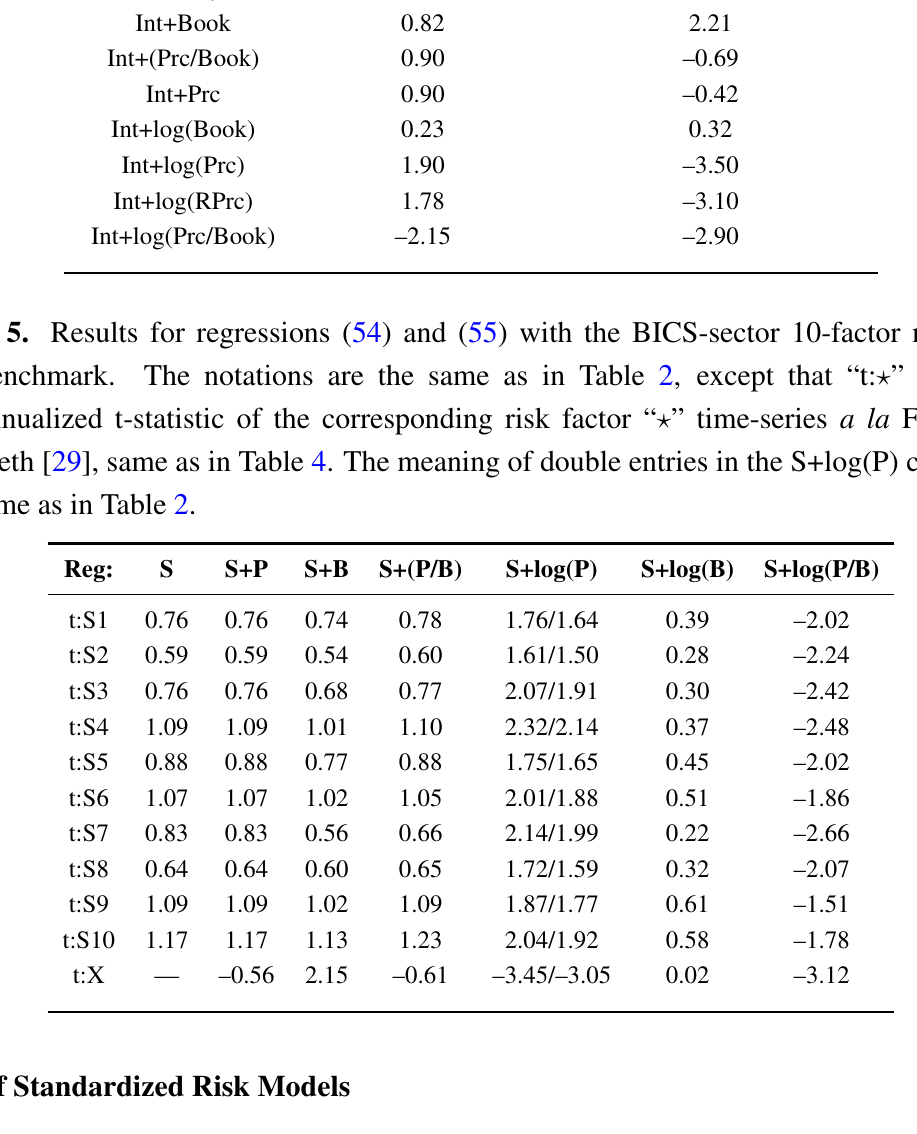
Table 4. Results for regressions (54) and (55) with the intercept-only 1-factor model as the benchmark. The notations are the same as in Table 1, except that the t-statistic here refers to